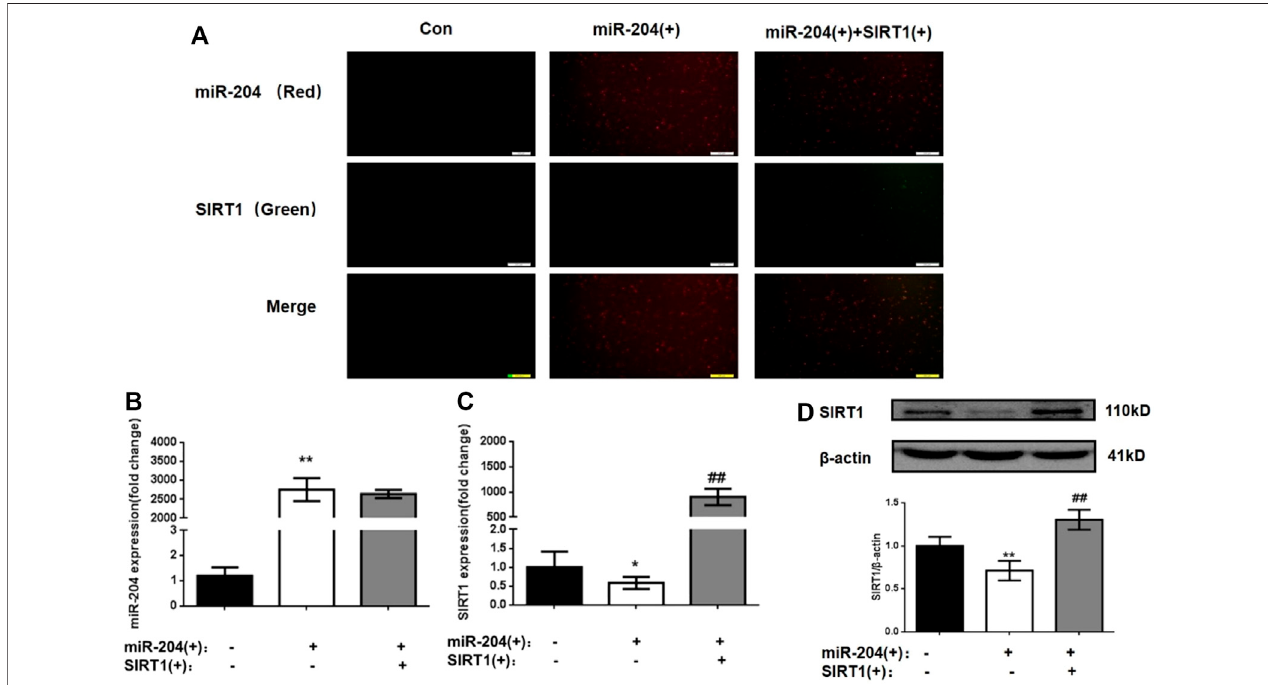
FIGURE 4 | Changes of miR-204 level, SIRT1 mRNA and protein expression in MIN6 cells after plasmid intervention. (A) The transfection ef fi ciency of MIN6 cells wasveri fi ed.thetransfectedmiR-204mimicshowedred fl uorescenceandtheSIRT1plasmidshowedgreen fl uorescence. (B) miR-204wasmeasuredbyRT-PCRafter miR-204 and SIRT1 over-expression. Data was expressed as means ± SEM ( n (cid:1) 4). ** p < 0.01, compared with control group. The mRNA (C) and protein level (D) of SIRT1weremeasuredaftermiR-204andSIRT1over-expression.Datawasexpressedasmeans ± SEM( n (cid:1) 4).* p < 0.05,** p < 0.01,comparedwithcontrolgroup; ## p < 0.01, compared with PA